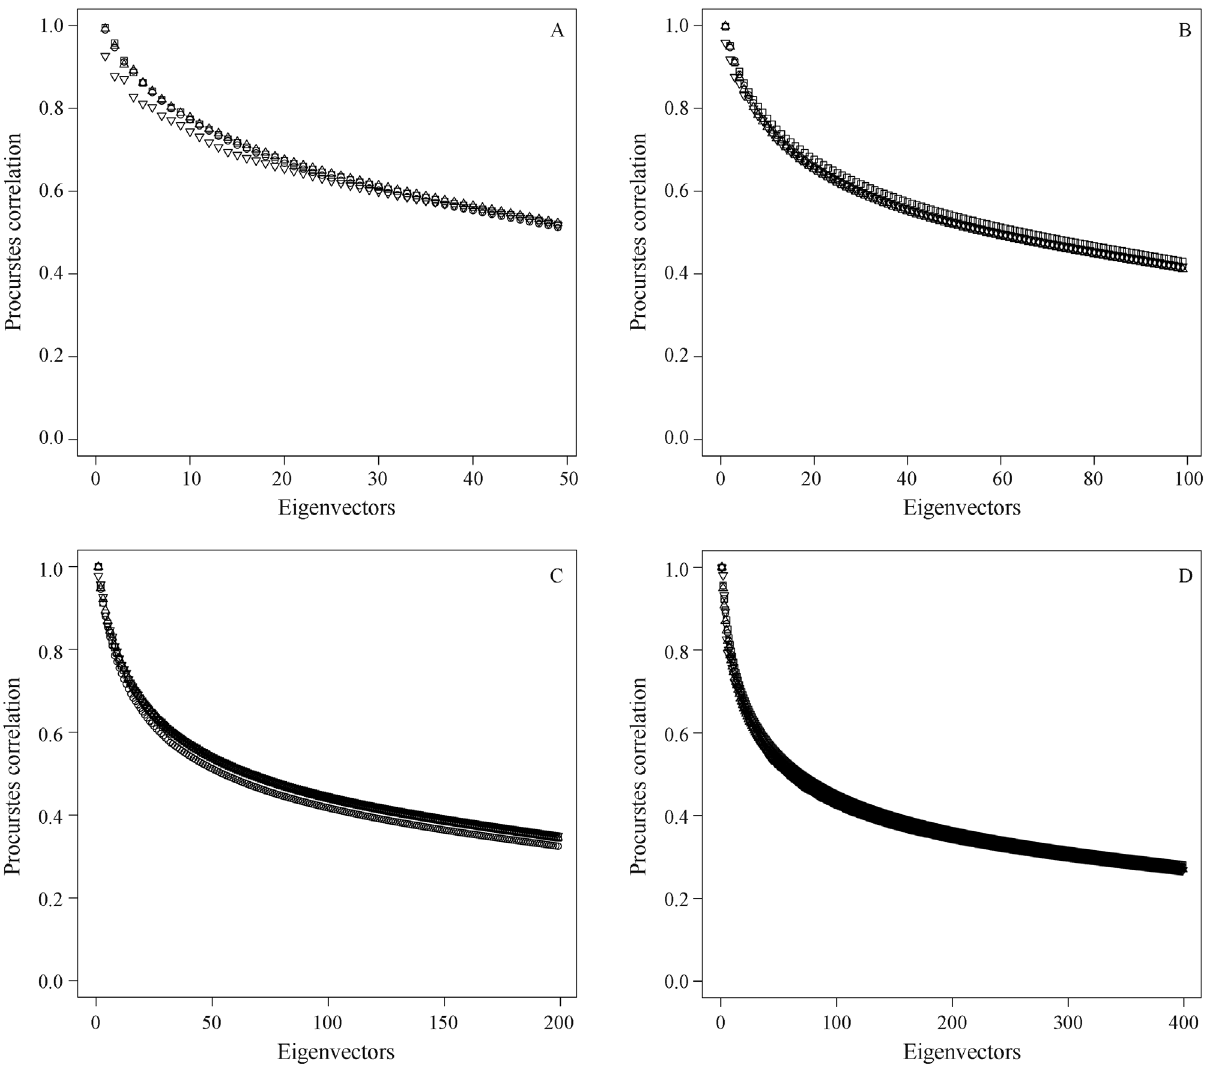
Figure 1 - Procrustes correlation between eigenvectors from PEM and PVR, for a successive set of eigenvectors extracted from phylogenies of (A) 50 species,(B)100species,(C)200species,and(D)400speciesandtraitsevolvingunderalternativeO-Umodels(opencircles: (cid:2) =0;opensquares: (cid:2) =0.5; open triangle point-up: (cid:2) = 1; open triangle point-down: (cid:2) =